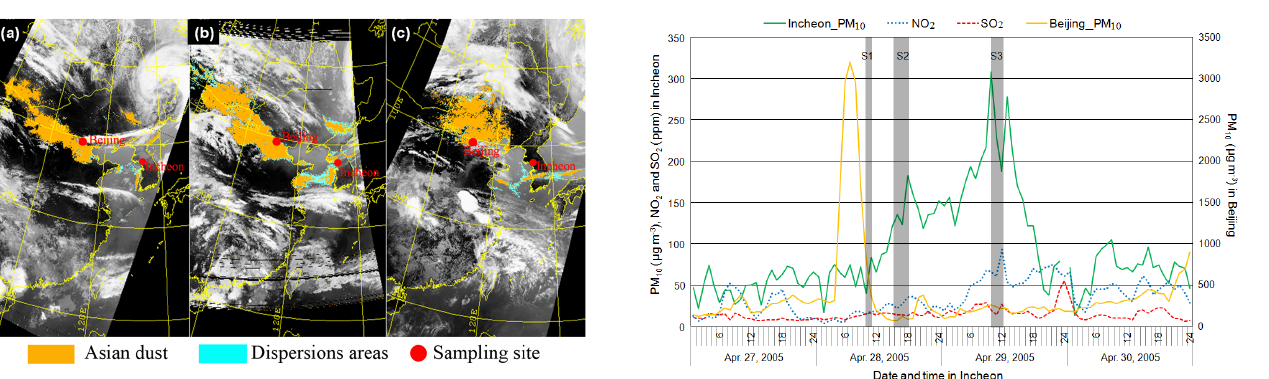
Fig. 2. Hourly values of PM 10 (in µgm − 3 ) , NO 2 and SO 2 concen- trations (in ppm) recorded in Incheon (left axis) and hourly values of PM 10 (in µgm − 3 ) recorded in Beijing (right axis) from 27 to 30 April 2005. The shadowed areas correspond (left to right) to the sampling times of the aerosol samples S1, S2, and S3. Sample S1 was collected in Beijing, China, while samples S2 and S3 were col- lected in Incheon,